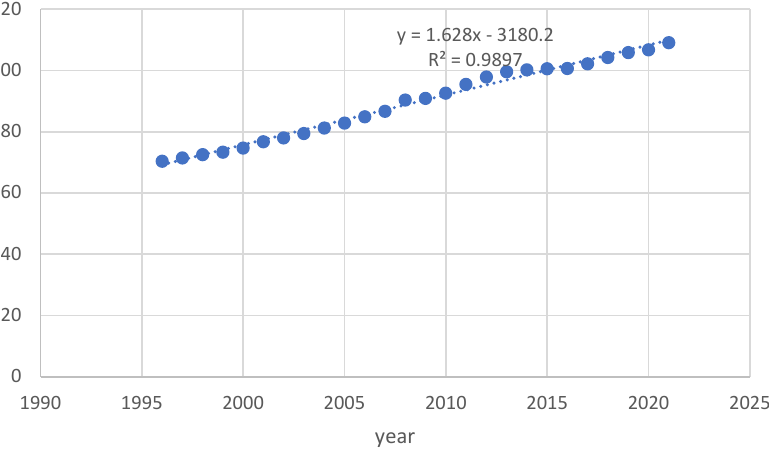
Figure 11. European Union (EU6-1958, EU9-1973, EU10-1981, EU12-1986, EU15-1995, EU25-2004, EU27-2007, EU28-2013, EU27-2020) harmonized CPI (reference 2015) from